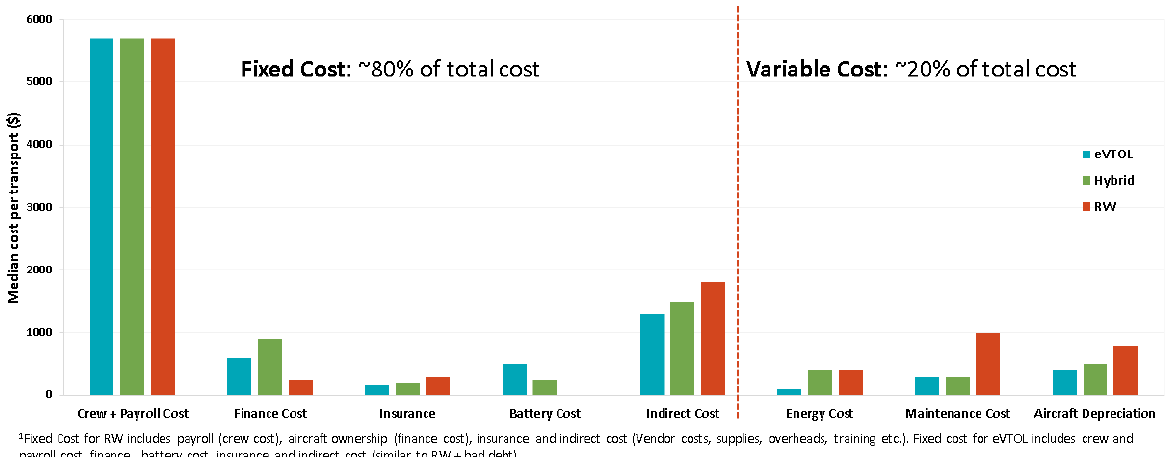
Figure 7. Fixed and variable cost comparison of eVTOL, hybrid, and rotary-wing (RW) aircraft.